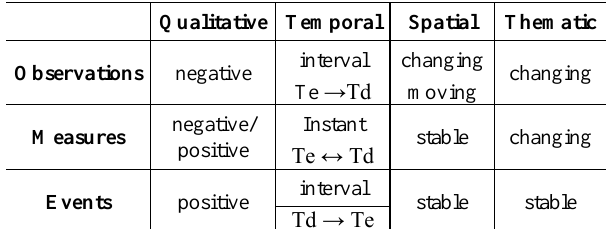
Table 2. Map elements classification according to geospatial data ontology. Te = Event Time, Td = database